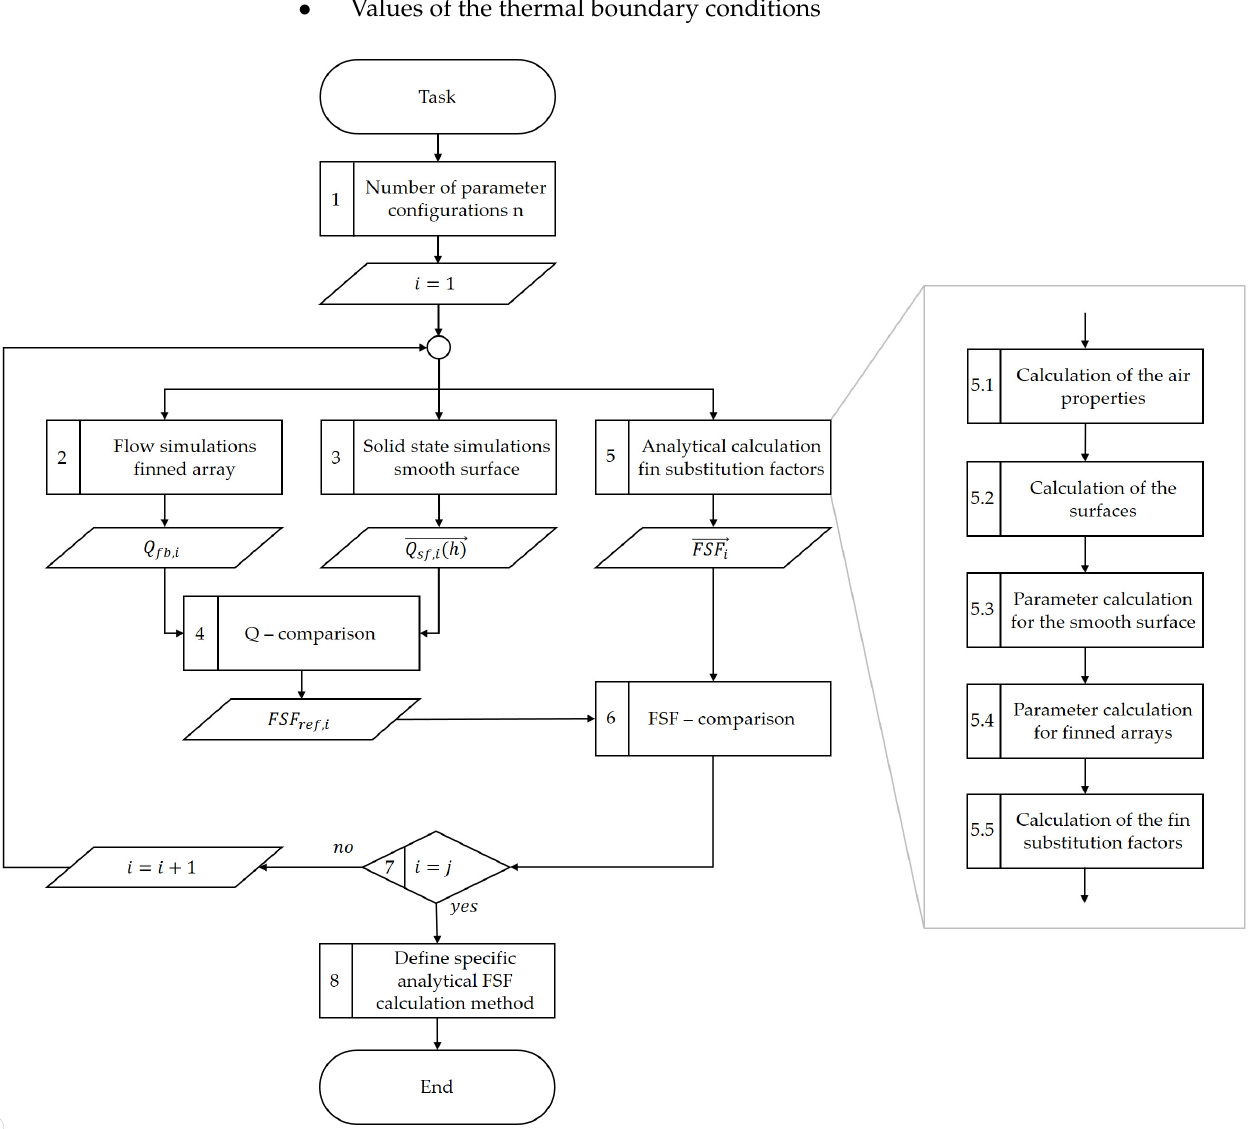
Figure 3. Process for determining the specific analytical FSF calculation method.